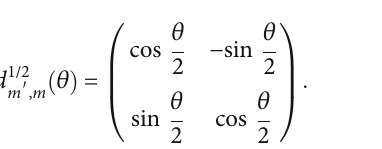
⟶ pK − π + toy amplitude model projections P Figure 3: Λ + c